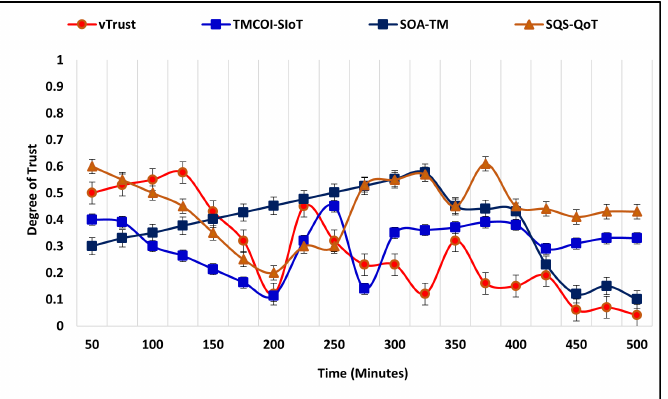
Figure 5. Malicious nodes detection with 100 nodes.